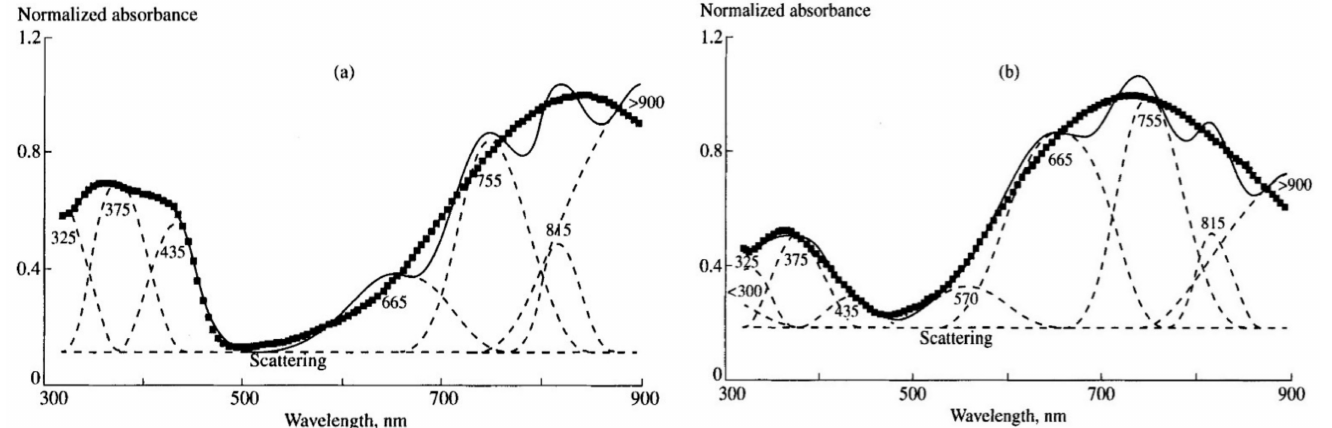
Figure 4. The results of deconvolution of PANI absorption spectra recorded in 1M aqueous HCl at 0.4 ( a ) and 0.8 ( b ) V. Reprinted by permission from Springer Nature Customer Service Centre GmbH: Springer Nature, Russian Journal of Electrochemistry, “Isolation of Individual Components in the Electronic Absorption Spectra of Polyaniline from the Spectroelectrochemical Data”, A. A. Nekrasov et al., Copyright 2000